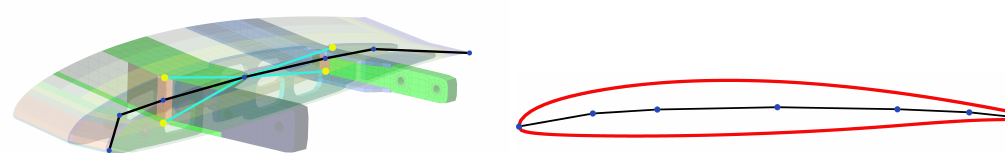
Figure 7. Doublet lattice representing FLEXOP UAV.